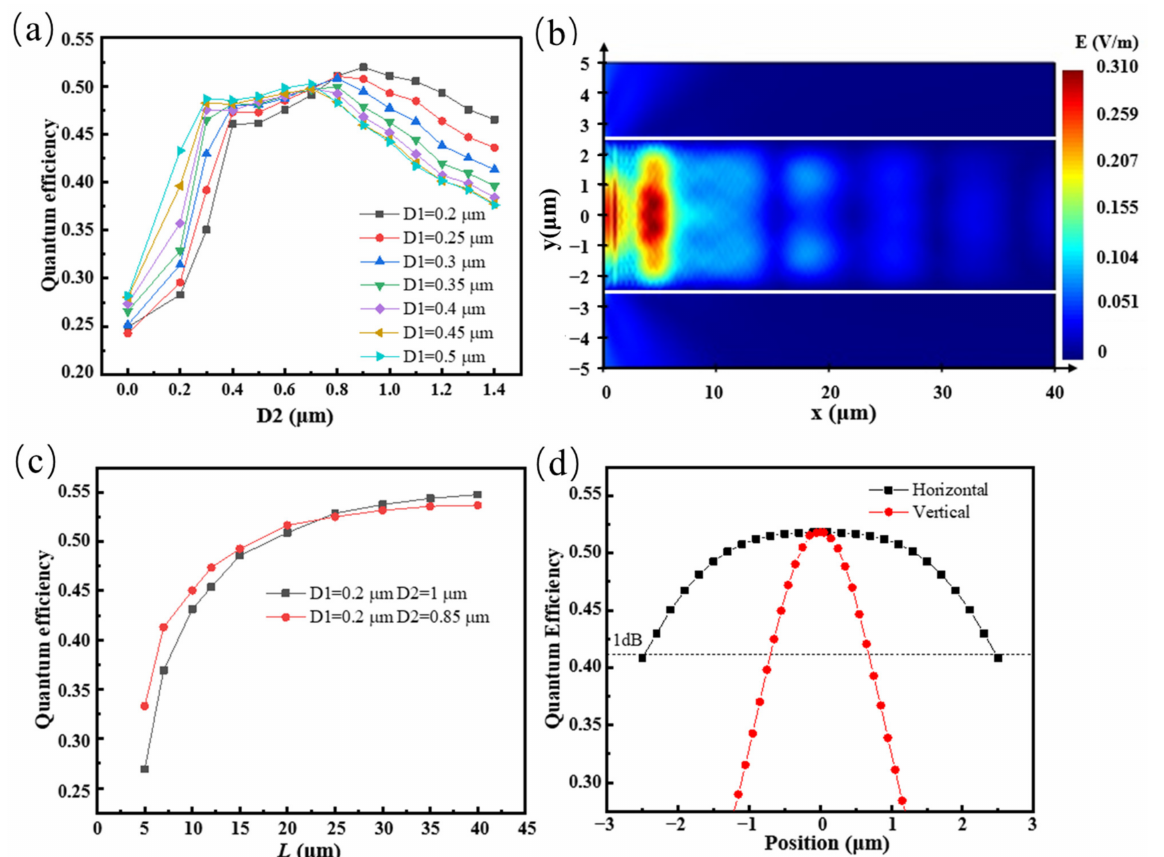
Figure 3. ( a ) Plots of simulated quantum efficiency versus InGa 0.24 As 0.53 P layer thickness D2 under different value of In 0.53 Ga 0.47 As layer thickness D1. ( b ) Simulated optical power transmission in the absorption region with a 0.2 µ m In 0.53 Ga 0.47 As absorption layer and a 0.85 µ m InGa 0.24 As 0.53